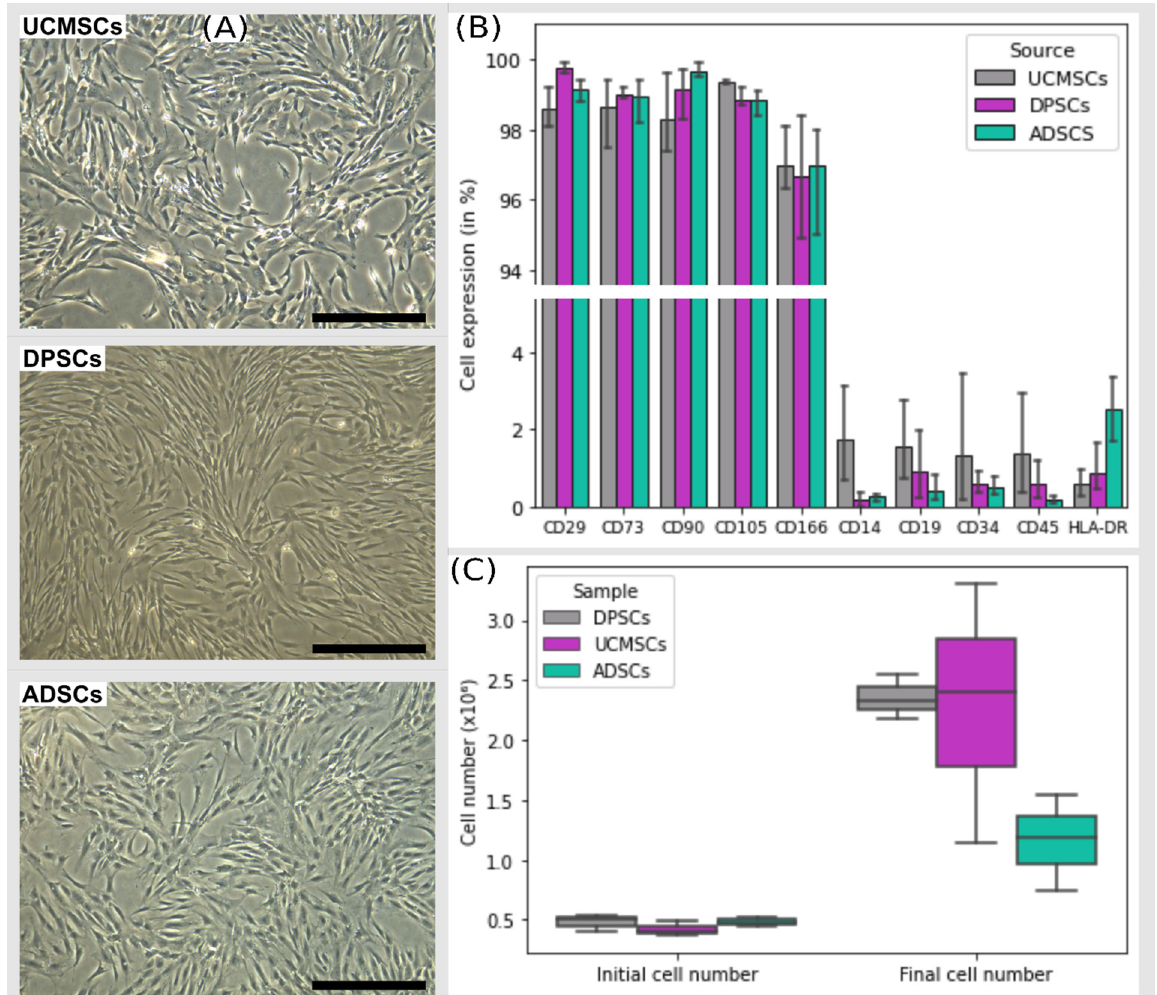
Figure 1. Representative image of MSC cultures from different sources and cell characterization.